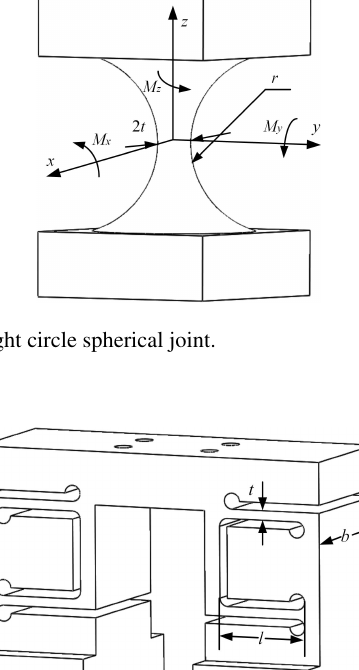
Fig. 3. The coordinate system o - xyz and o (cid:48) - x (cid:48) y (cid:48) z (cid:48)